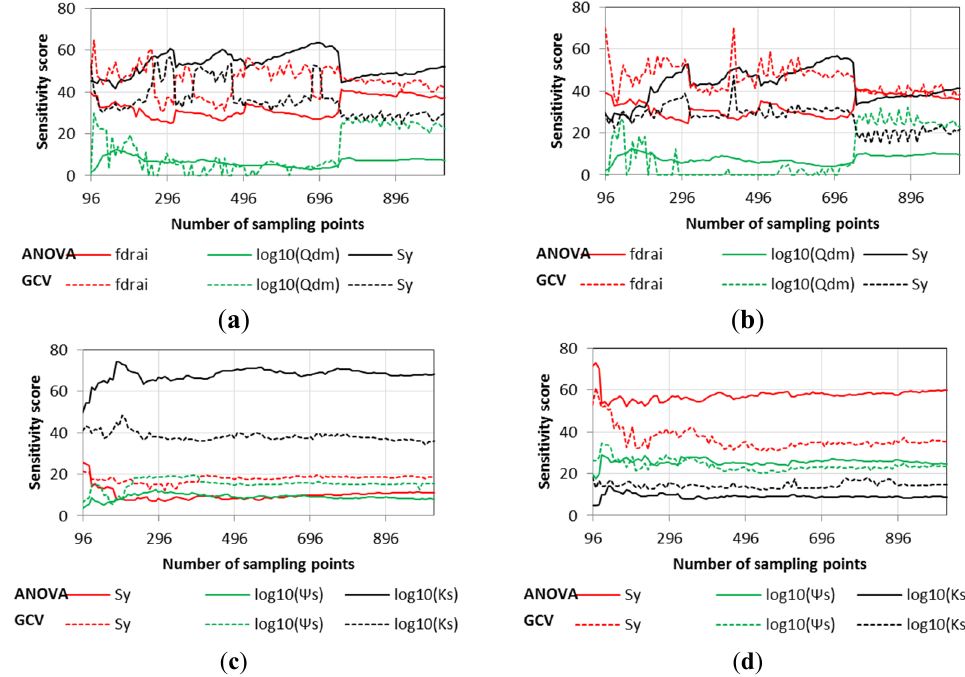
Figure 6. Sensitivity scores convergence for different response variables and SA approaches. ( a ) NSC of runoff (1st order); ( b ) NSC of qdrai (1st order); ( c ) NSC of qover (1st order); ( d ) NSC of LH (1st order).